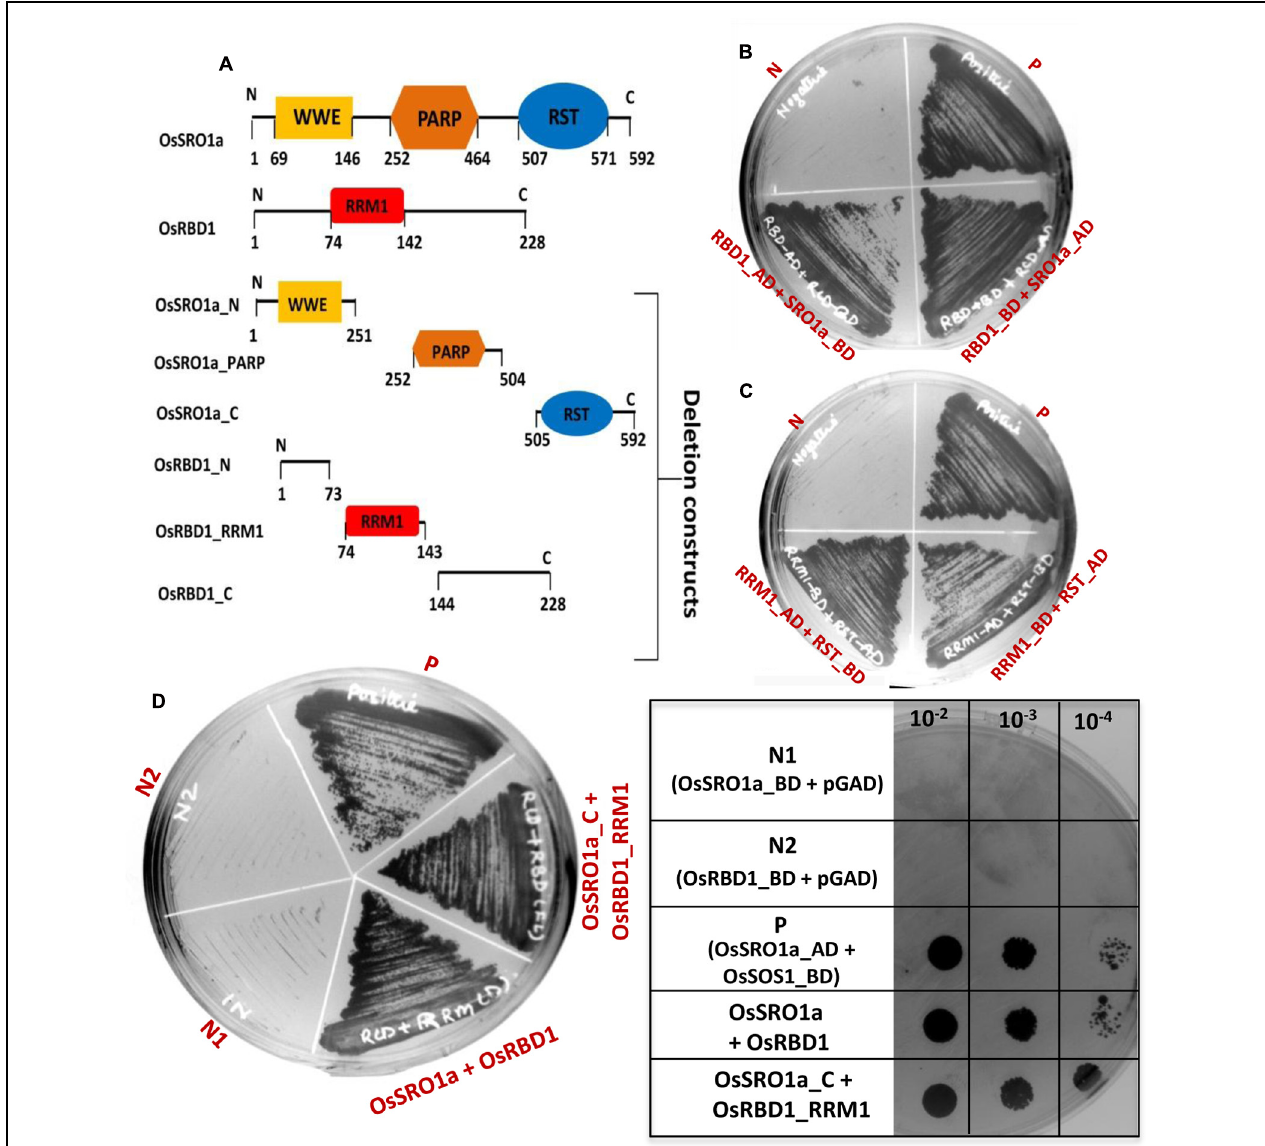
FIGURE 2 | RST domain of OsSRO1a interacts with RRM1 domain of OsRBD1. (A) Schematic representation of the domains present in OsSRO1a and OsRBD1 proteins and various deletions constructs prepared for domain–domain interaction studies. (B) Growth observed after co-transforming full-length OsRBD1 (in pGAD vector) and OsSRO1a (in pGBD vector), and OsRBD1 (in pGBD vector) and OsSRO1a (in pGAD vector), and (C) after co-transforming OsRBD1_RRM1 (in pGAD vector) and OsSRO1a_RST (in pGBD vector), and OsRBD1_RRM1 (in pGBD vector) and OsSRO1a_RST (in pGAD vector) on four drop-out + 3-AT (20 mM) medium. (D) Growth observed after streaking co-transformed full-length OsRBD1 and OsSRO1a (OsSRO1a + OsRBD1) and OsSRO1a_C and OsRBD1_RRM1 (SRO1_C + RRM1) on four drop-out + 20 mM 3-AT medium (left panel) and spotting serial dilutions of the same (right panel). P is the positive control taken as OsSRO1a-pGAD + OsSOS1-pGBD, and N, N1, and N2 are the negative controls, representing co-transformed empty vectors, OsSRO1a_BD + pGAD and OsRBD1-BD + pGAD, respectively. The data shown is representative of three clones used for each construct and experiment was repeated